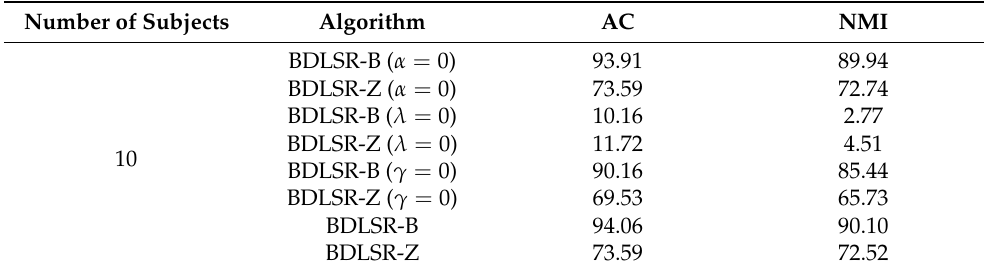
Table 9. A comparison of the results from the different algorithms when using the Extended Yale B dataset in the ablatio studies